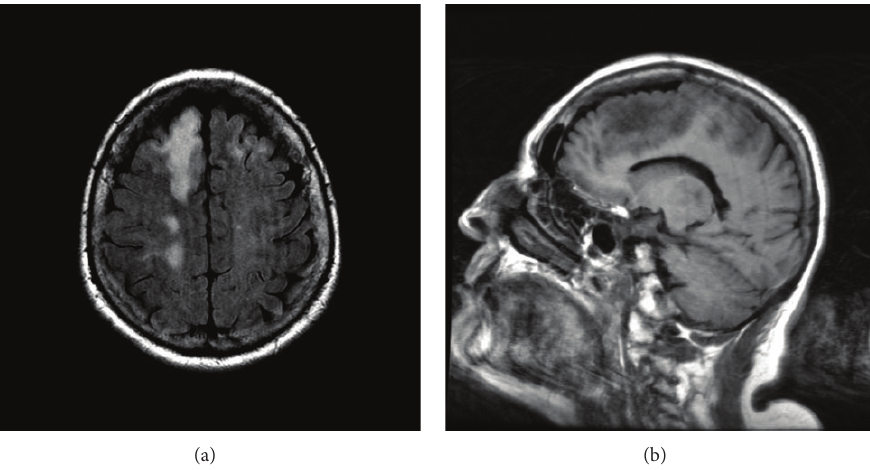
Figure 1: (a) T2 FLAIR: confluent hyperintense lesion in R hemisphere over R frontal region, R motor cortex. Involvement of U fibers. Minimal perilesional edema. Few lesions are seen in left frontal region as well. (b) Sagittal T1 images show hypointense lesion in the left frontal regions corresponding to the axial